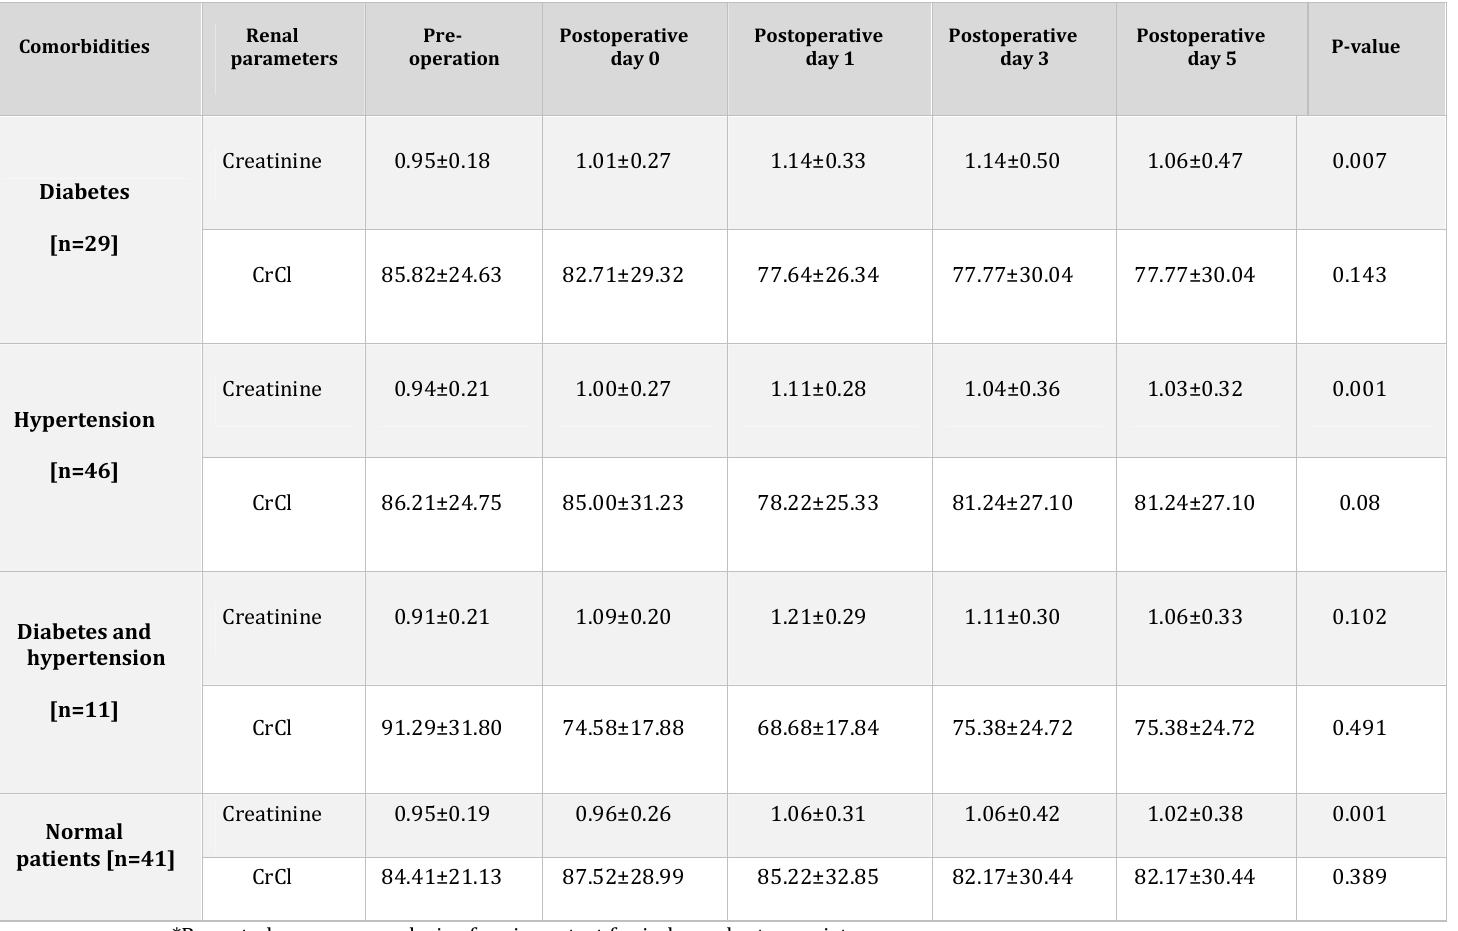
Table 4. Comparing preoperative and postoperative Creatinine and creatinine clearance [CrCl] of patients with diabetes, hypertension, both diabetes and hypertension, and normal patients in on-pump group